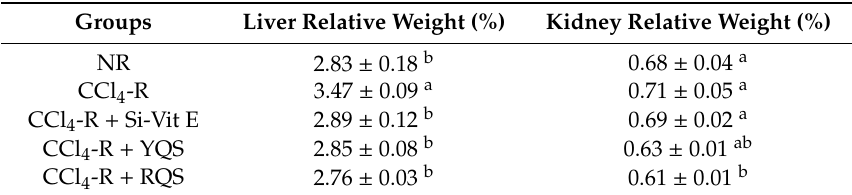
Table 3. E ff ect of quinoa extracts on the relative weight of livers and kidneys of rats with CCl 4 -induced oxidative stress (mean ± SE), n = 6.